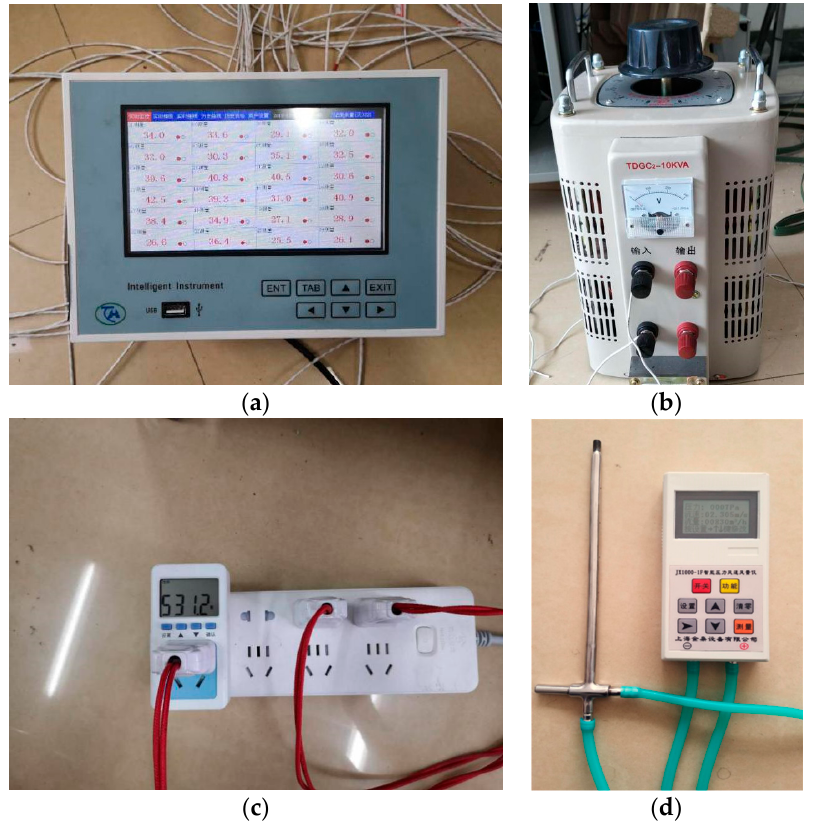
Figure 15. Images of ( a ) temperature display, ( b ) voltage-controlled power source, ( c ) digital wattmeter and ( d ) intelligent pressure anemoscope.